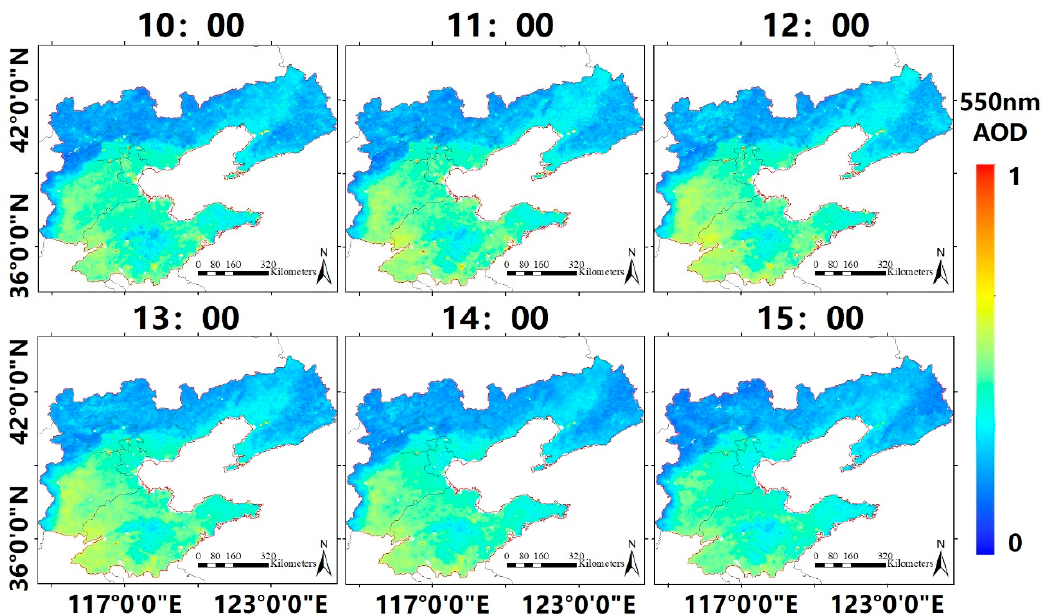
Figure A1. Hourly AOD distribution during 2018 over Bohai Rim region, China.